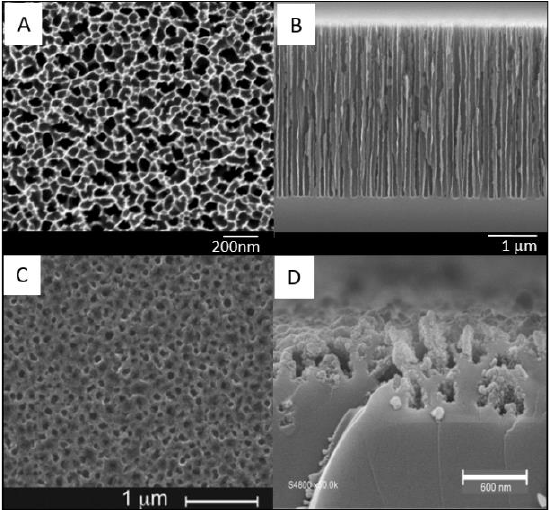
Figure 2. The NIMS surface morphology is shown by scanning electron microscopy in the top and cross-sectional views ( A,B ). The pore size of NIMS was estimated between 80 and 100 nm in diameter, and the pore depth of NIMS was 3.5 µm ( B ). The average pore size of DIOS was 120 nm, and the average pore depth was 450 nm. The image of the DIOS surface ( C , D ) was reprinted with permission from Ref. [23]. Copyright (2015), Elsevier.